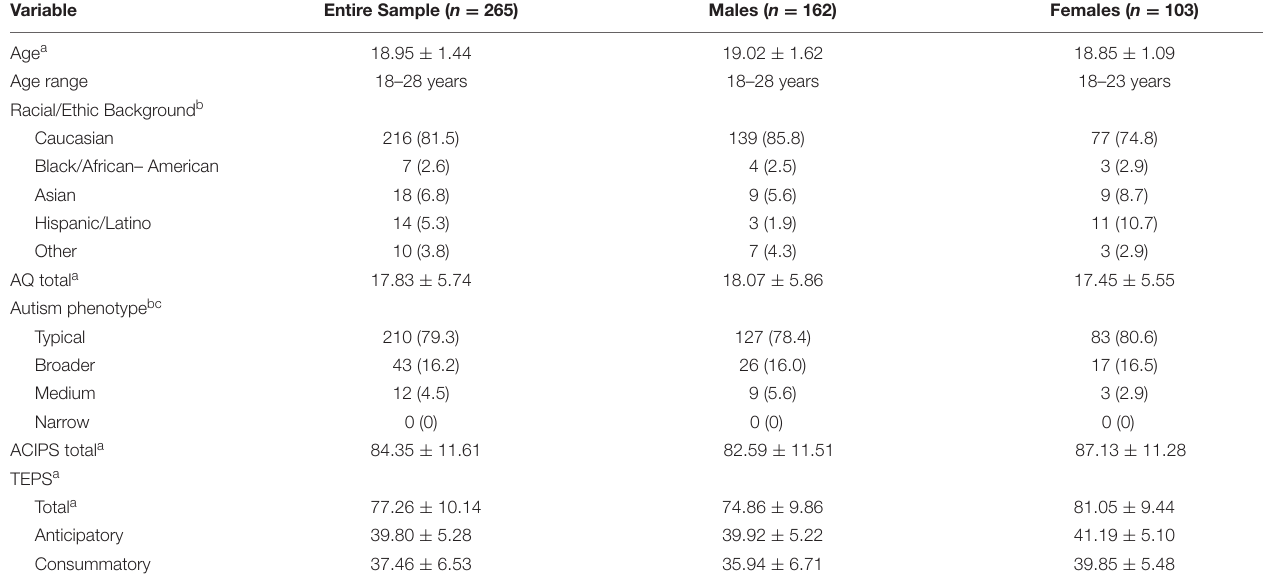
TABLE 1 | Demographic characteristics and descriptive statistics for the self-report measures.